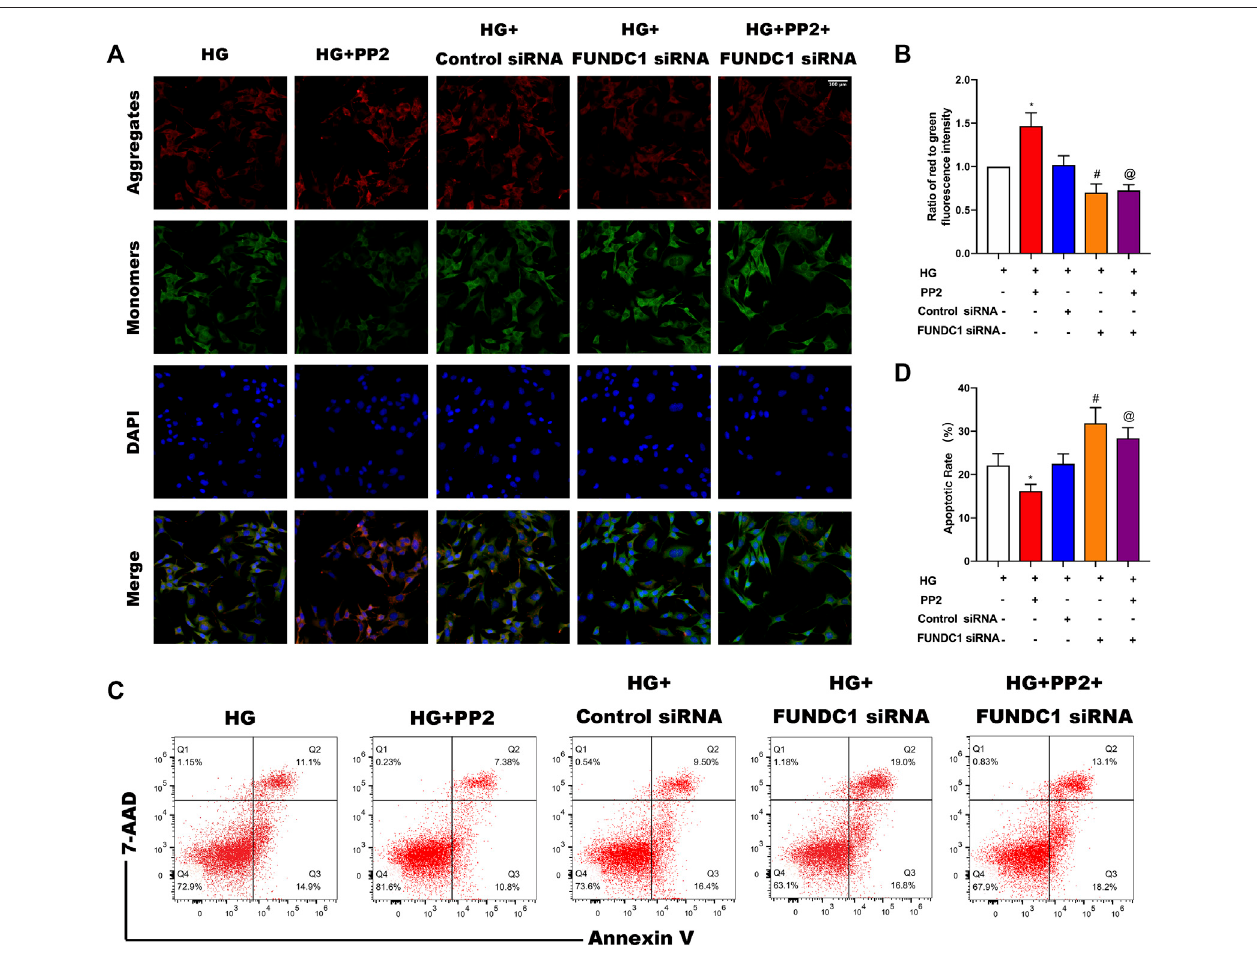
FIGURE 7 | Silencing of FUNDC1 eliminates the protective effects of PP2 on podocytes exposed to HG conditions. (A) JC-1 staining to detect MMP. (Magni fi cation, 200 ×). (B) MMP measured as the ratio of red to green fl uorescence intensity from (A) . (C) Flow cytometry analysis of apoptosis in podocytes after the indicated treatments. (D) Quantitation of podocyte apoptosis from (C) . Values are expressed as the mean ± SD, * p < 0.05 vs. HG group, # p < 0.05 vs. HG + Control siRNA group, @ p < 0.05 vs. HG + PP2